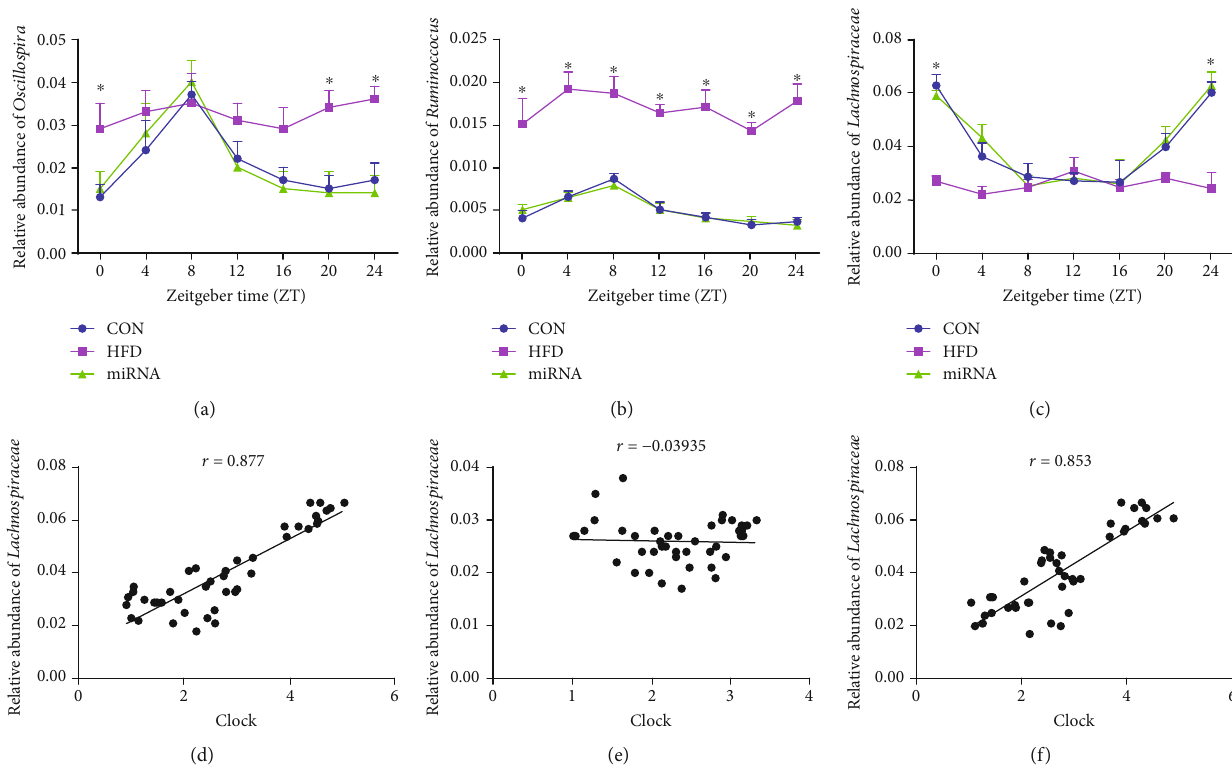
Figure 3: E ff ects of miRNA-10a-5p on diurnal rhythms of gut microbiota in high-fat diet-fed mice. (a) Relative abundance of Oscillospira ; (b) relative abundance of Ruminococcus ; (c) relative abundance of Lachnospiraceae ; correlation between triglyceride content and Clock expression in CON group (d), HFD group (e), and miRNA group (f). TG: glycerides; Chlo: cholesterol. Data were expressed as Mean ± SEM . ∗ P < 0 : 05 .